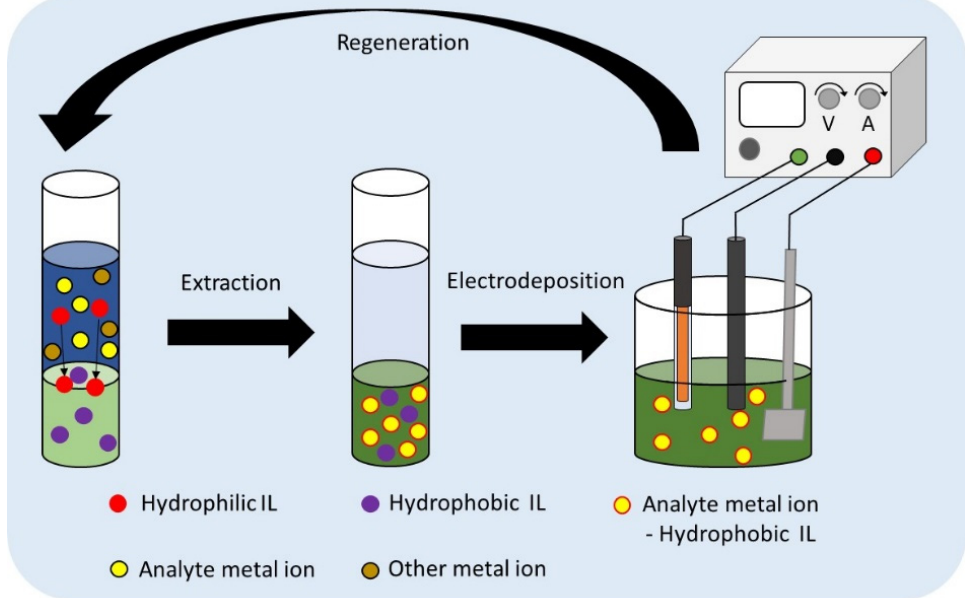
Figure 4. Extraction–electrodeposition process of metals in hydrophilic and hydrophobic